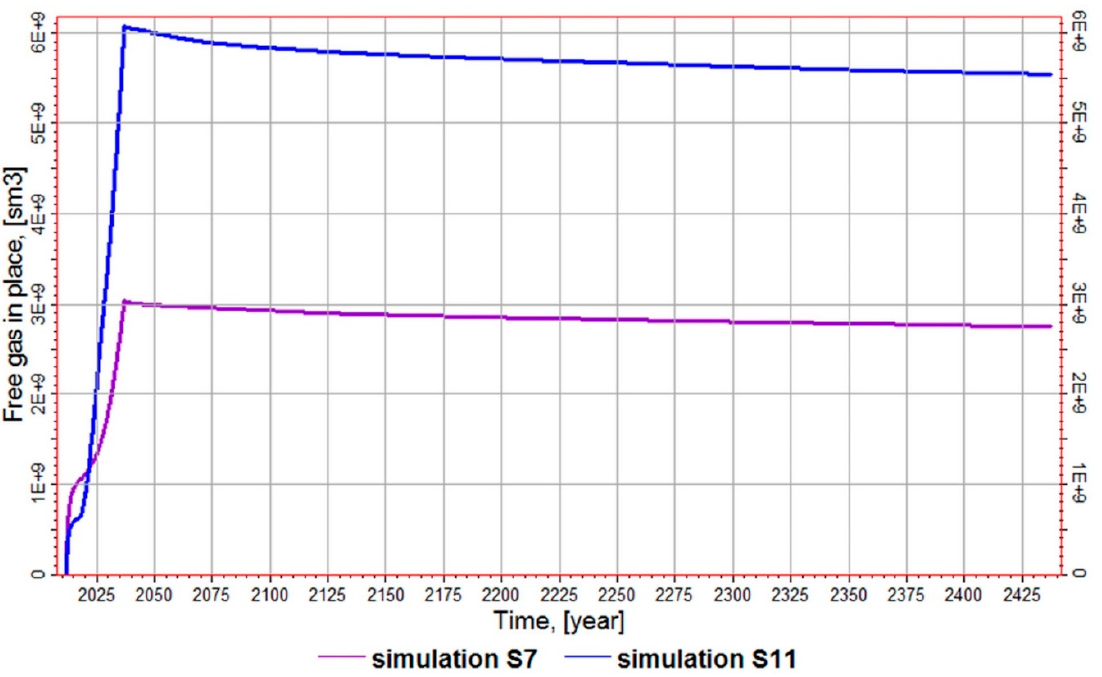
Figure 10. Comparison of the free-phase CO 2 reduction process in the structure for variants 7 and 11 over time.